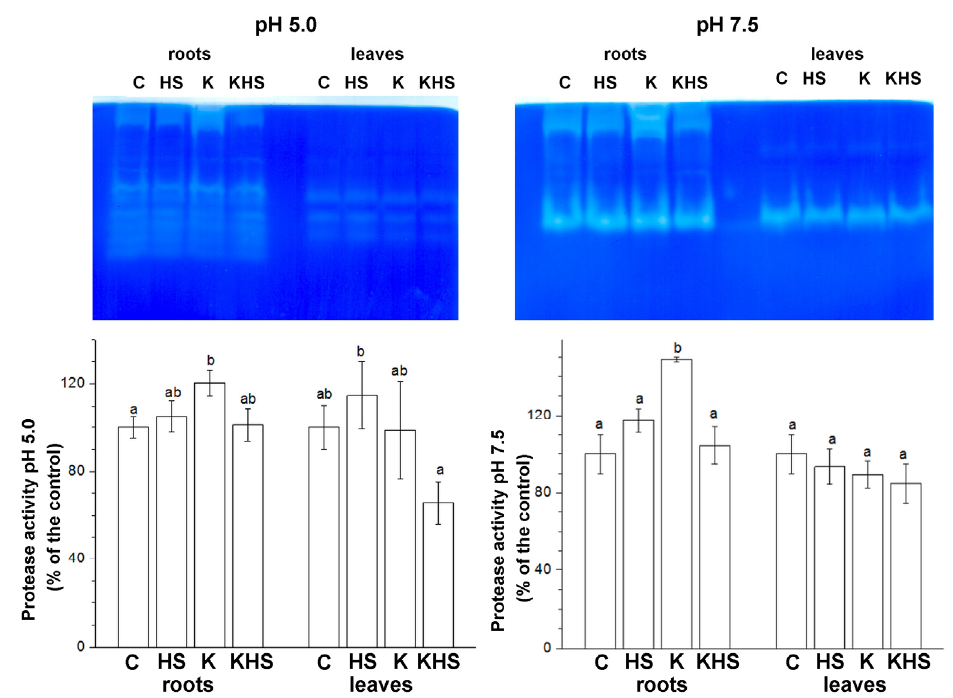
Figure 6. In-gel staining of acidic (pH 5.0) and neutral (pH 7.5) protease activity. Protein loading on each lane equals 25 μ g of total soluble protein for the root samples and 50 μ g of total soluble protein for the leaf samples. The graphs represent mean values of three separate measurements of the staining intensity performed with ImageJ ( n = 3 ± SE). The results are expressed as % of the control. Different letters above the columns indicate significant differences at p < 0.05 (multifactor ANOVA).